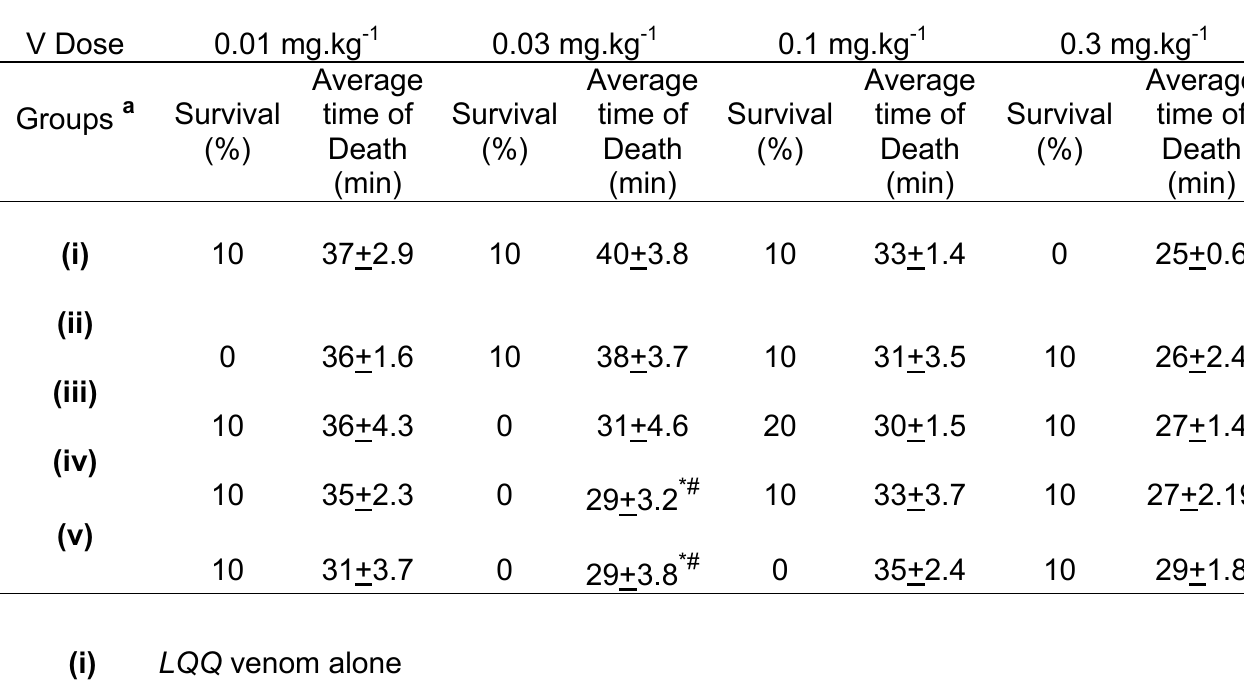
Table 6: Percent survival and average time of death of mice intravenously injected with verapamil (V) at different times before and after LQQ venom (300 (cid:80) g.kg -1 ,